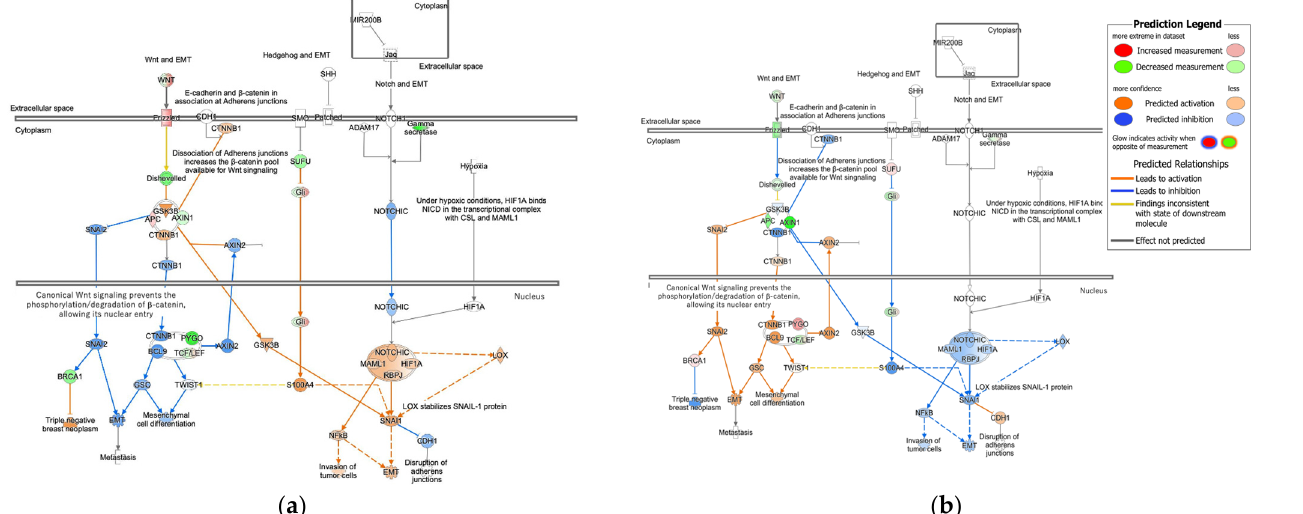
Figure 2. Molecular activity prediction in regulation of the EMT in development pathway in diffuse- and intestinal-type GC. ( a ) Molecular activity prediction in diffuse-type GC; ( b ) molecular activity prediction in intestinal-type GC. Red or green color indicates upregulated or downregulated genes, respectively. The intensity of colors indicates the degree of up- or downregulation. A solid or dashed line indicates direct or indirect interaction, respectively. Orange or blue color indicates predicted activation or inhibition, respectively. The intensity of colors indicates the confidence level of the prediction.